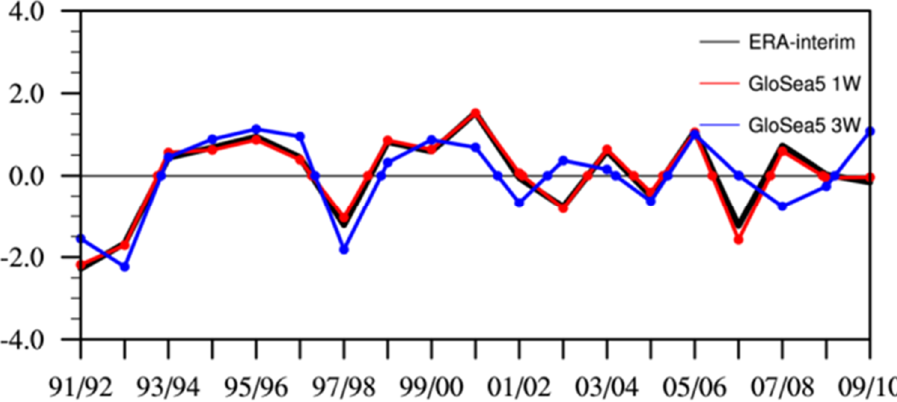
Figure 3. Time series of East Asia winter monsoon index as given by Li and Yang (2010) from ERA−Interim and GloSea5 with lead times of 1 ( red ) and 3 ( blue ) weeks.